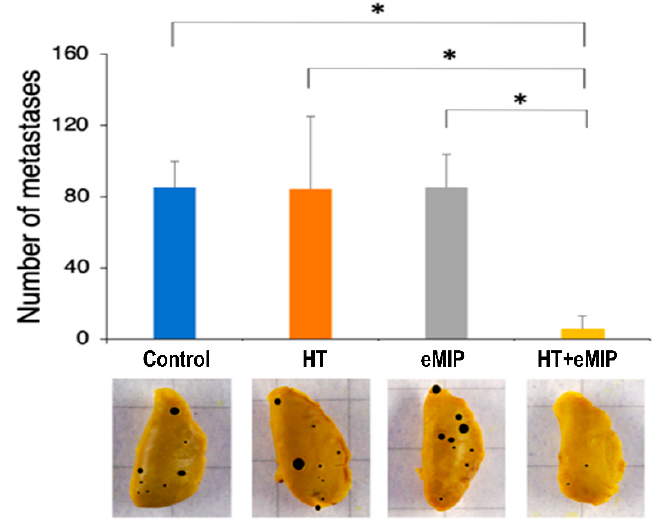
Figure 2. Numbers of lung nodules at 18 days after HT treatment. ( Top ) Mean numbers of metastatic nodules. Error bars show standard deviation ( n = 6). * p < 0.05 (ANOVA). ( Bottom ) Photographs of left upper lobe from control, HT, eMIP and HT + eMIP group mice are shown as representatives.